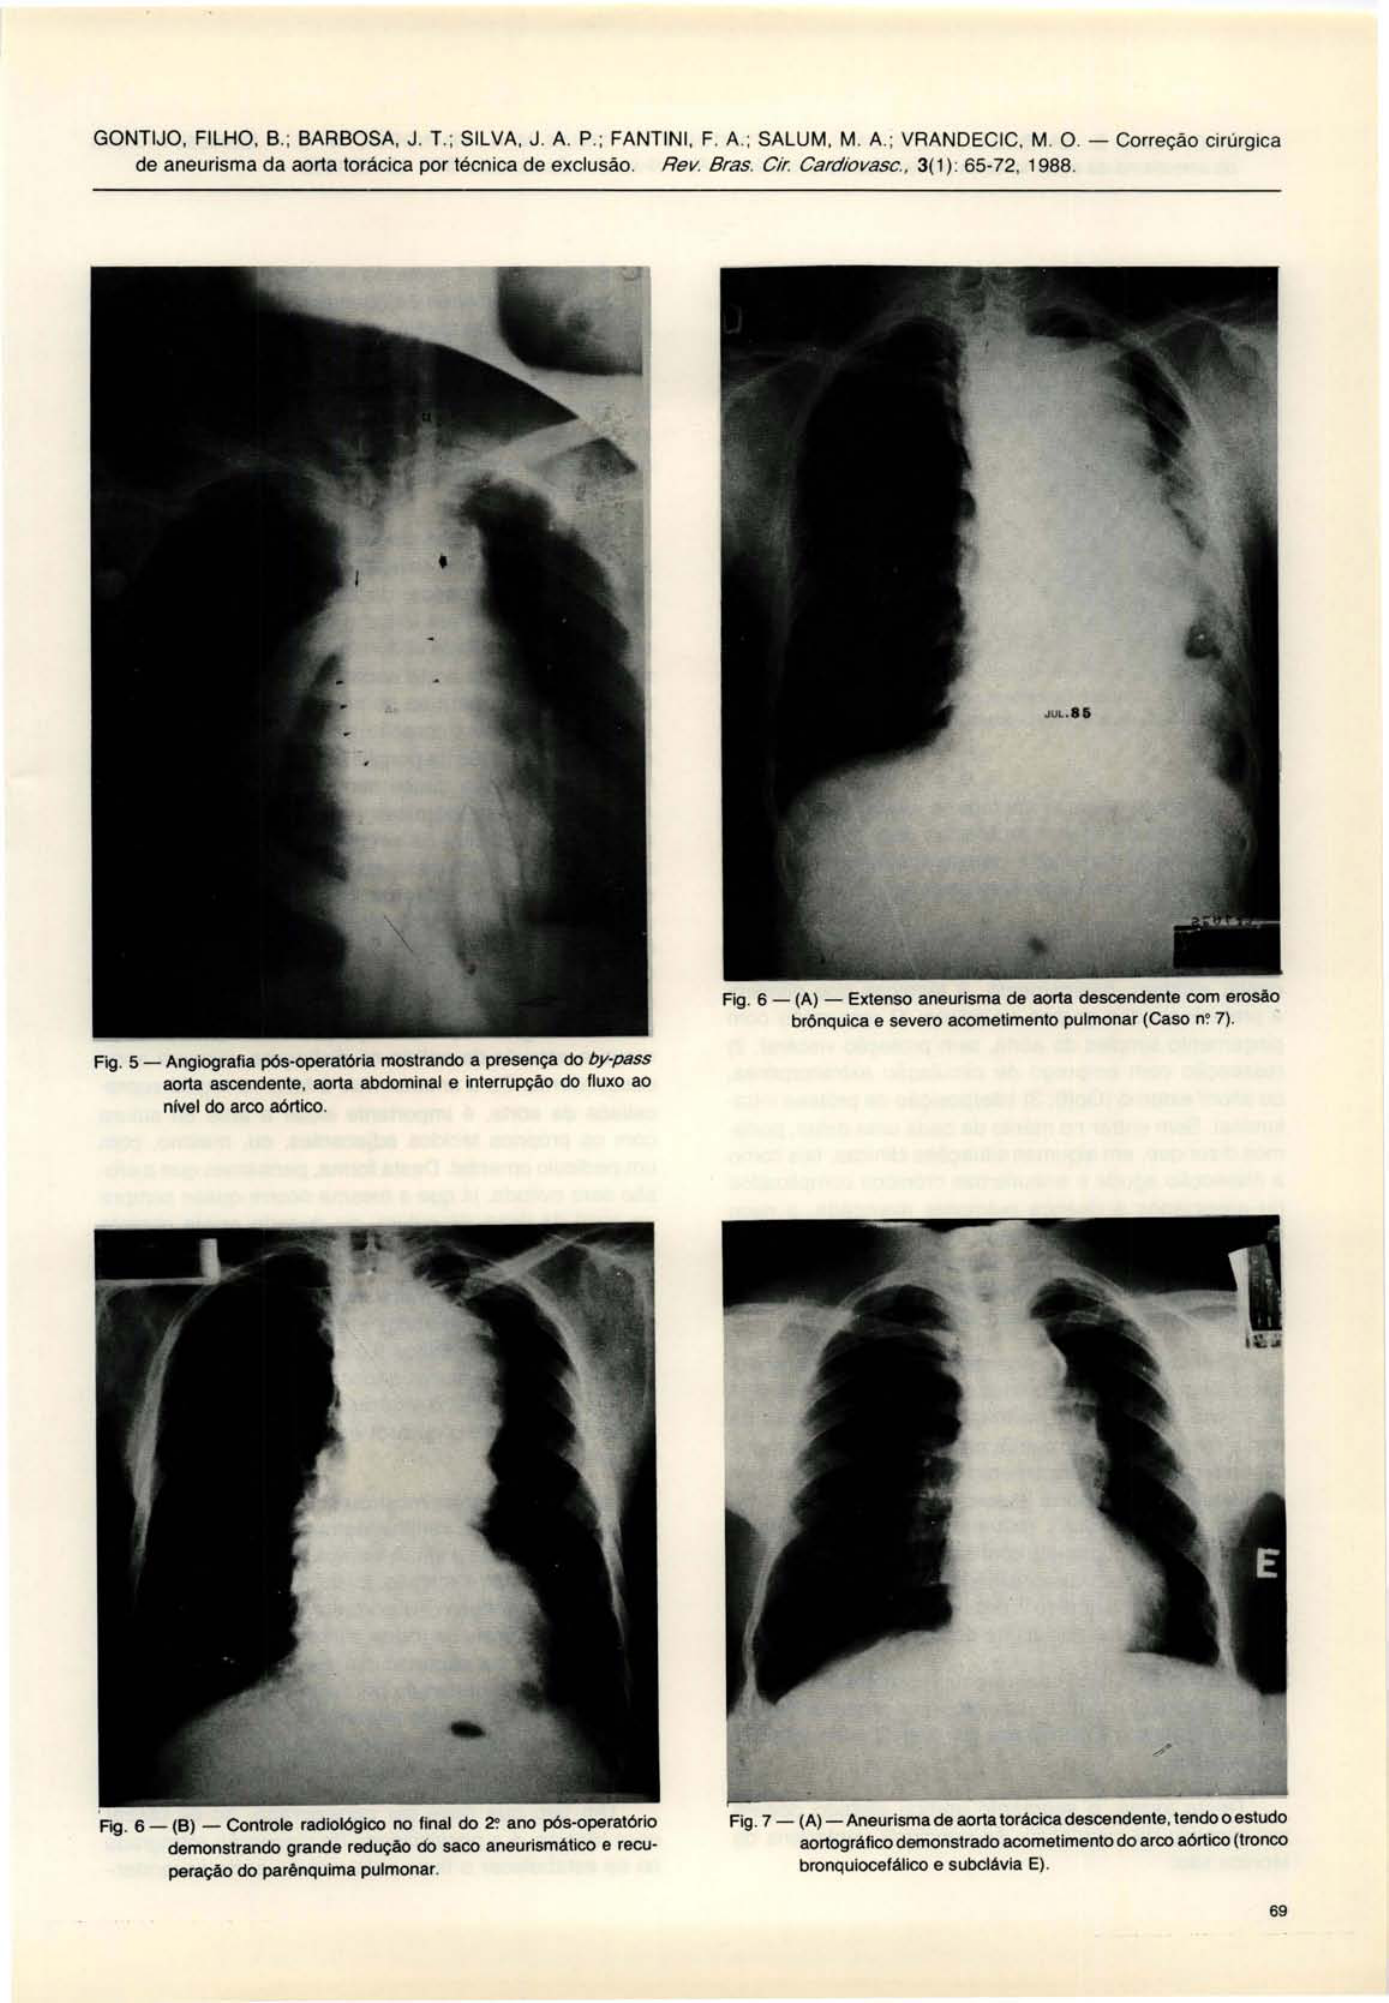
Fig. 6 - (B) - Controle radiológico no final do 2'? ano pós-operatório demonstrando grande redução do saco aneurismático e recu peração do parênquima pulmonar.